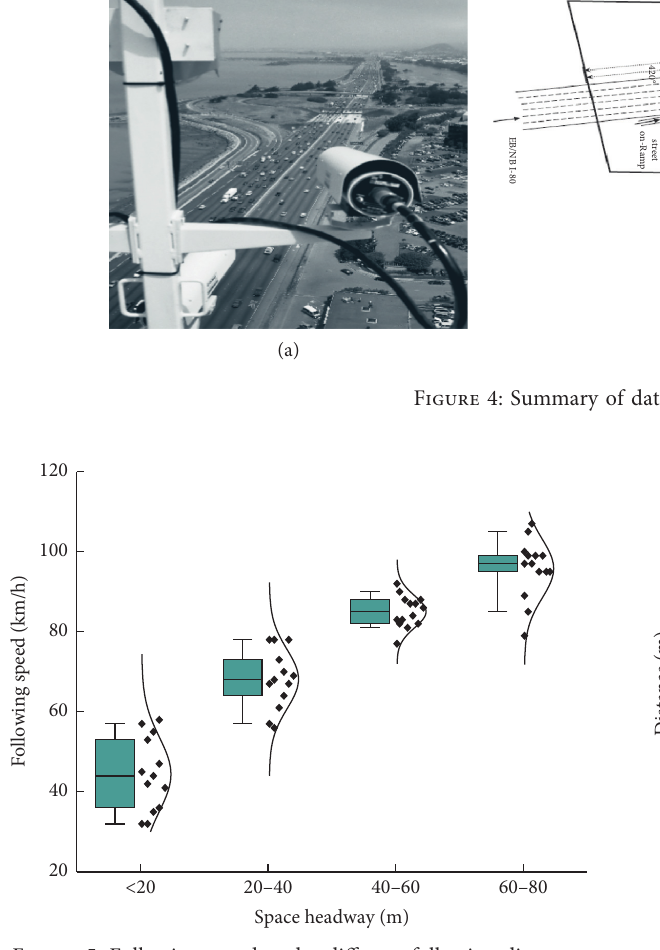
Figure 5: Following speed under different following distance.